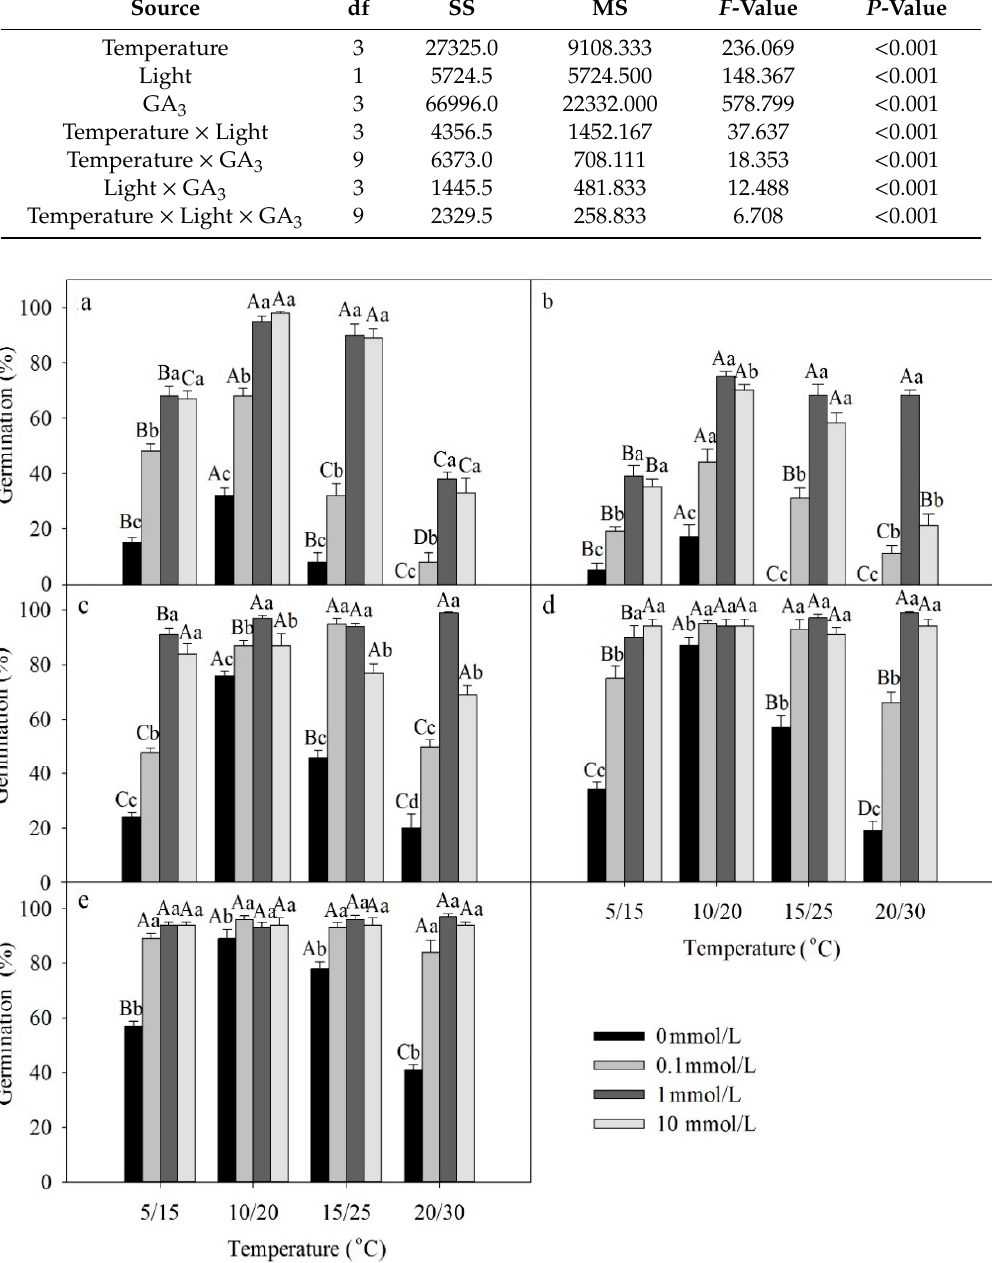
Figure 2. Effects of GA 3 and temperature on germination percentage of seeds of Lepidium apetalum (mean ± SE) on germination of ( a ) freshly matured seeds in light, ( b ) freshly matured seeds in darkness, ( c ) 1-month dry stored seeds in light, ( d ) 2-month dry stored seeds in light, and ( e ) 3-month dry stored seeds in light. Different uppercase letters indicate significant differences among temperatures (within a GA 3 concentration) and lowercase letters indicate differences among GA 3 concentration (within a temperature) (5% level). Table 3. Three-way ANOVA results testing the effects of storage time, GA3, temperature and their interactions on germination of Lepidium apetalum seeds stored dry for 1, 2, and 3 months. df, degree of freedom; MS, mean square; SS, sum of squares.